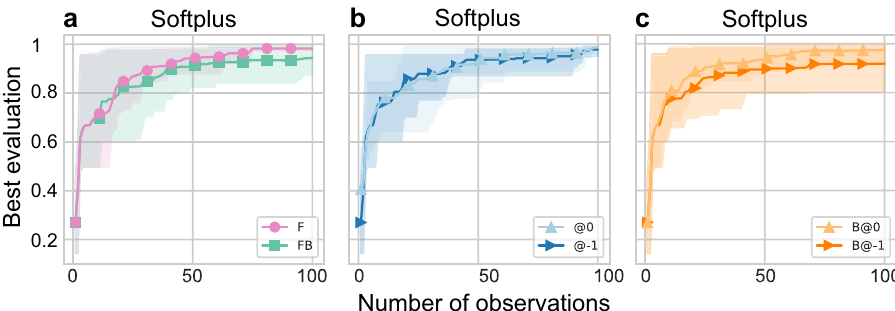
Fig. 4 Parameter search results for the Softplus function. Best evaluation values averaged over fi ve runs as a function of the number of observations. Shaded areas indicate the range of the best and worst values of fi ve runs. a Methods F and FB that adaptively replace failed evaluations by the fl oor padding. b Baseline methods that use a constant value for the failed evaluations. Method @0 used the fi xed value of 0 when the experiment failed, whereas @ − 1 used − 1. c Methods with classi fi er while padding a constant to failures. B@0 used a value of 0 as the evaluation when the experiment failed, whereas B@ − 1 used −